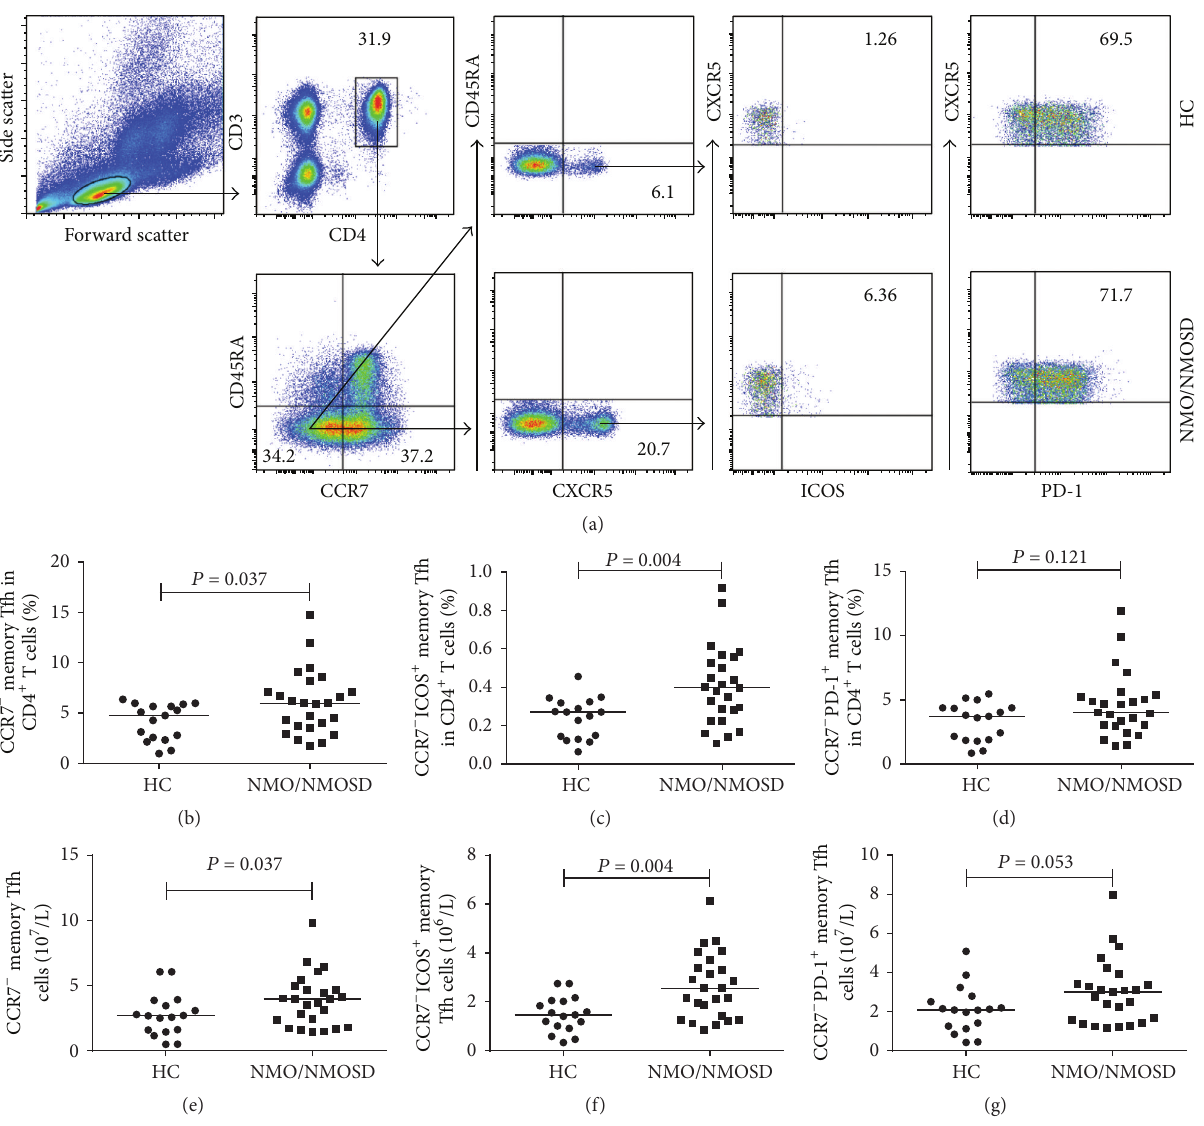
Figure 3: FACS analysis of circulating CCR7 − and CCR7 − ICOS + memory Tfh cells in individual participants. After staining with different fluorescent antibodies, the cells were gated sequentially on lymphocytes, CD3 + and CD4 + , and then CD45RA − and CCR7 − cells. After that, the cells were gated on CXCR5 and we obtained CD3 + CD4 + CD45RA − CCR7 − CXCR5 + (CCR7 − memory Tfh) cells. Subsequently, CCR7 − memory Tfh cells were gated on ICOS expression, and the percentages of CCR7 − and CCR7 − ICOS + memory Tfh cells were analyzed by flow cytometry. The numbers of each subtype of cells were calculated. (a) Flow cytometric analysis. ((b)-(c)) The percentages of circulating CCR7 − and CCR7 − ICOS + memory Tfh cells in HCs and untreated NMO/NMOSD patients. ((d)-(e)) The numbers of circulating CCR7 − and CCR7 − ICOS + memory Tfh cells in HCs and untreated NMO/NMOSD patients. The horizontal lines indicate the median values for each